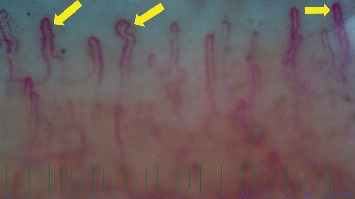
Nail fold capillaroscopic changes in a 10 years old boy with juvenile systemic lupus erythematosus and nephritis. Arthritis following nephritis and hematologic involvement was presented at 5 years old as the first manifestations. The increased diameter in the irregular pattern was demonstrated in the nail fold capillaroscopy of this patient.